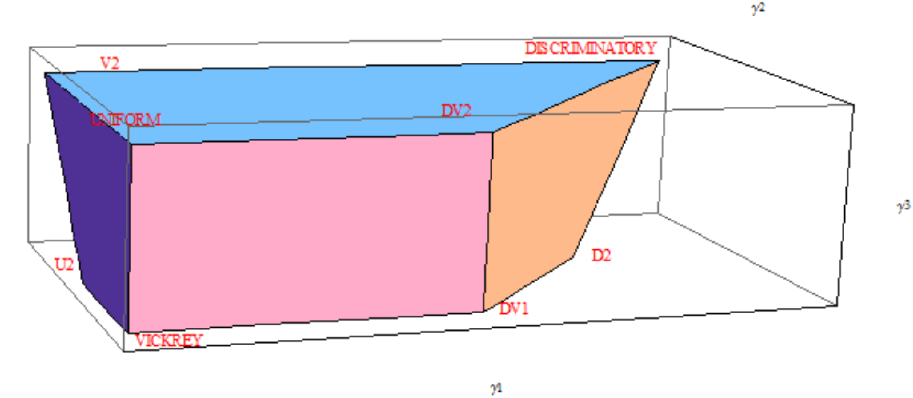
Figure 3. Graphical representation of the parametric family of auction mechanisms for three objects with α 1 = 1, α 2 = 0.3 and α 3 = 0.1. Each vertex correspond to a combination of the parameters γ 1 , γ 2 and γ 3 .